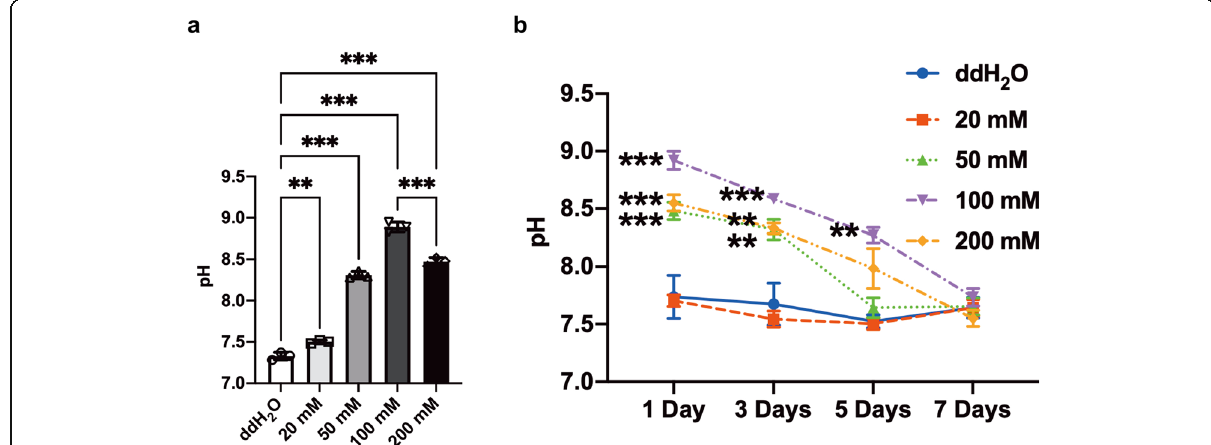
Fig. 4 pH value of different concentrations (0 mM, 20 mM, 50 mM, 100 mM and 200 mM) of sodium bicarbonate solutions ( a ); variation of the pH value in culture media with time post cell seeding on SLA surfaces treated with different concentrations of sodium bicarbonate ( b ). Data are presented as the mean ± standard deviation ( n = 3, * P < 0.05; ** P < 0.01; *** P <